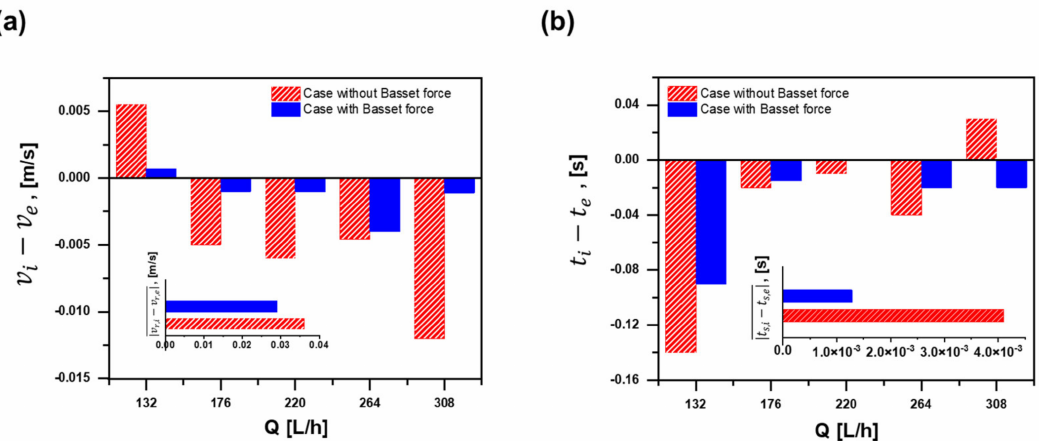
Figure 6. Error with the experiment: ( a ) time to reach liquid surface; ( b ) rising